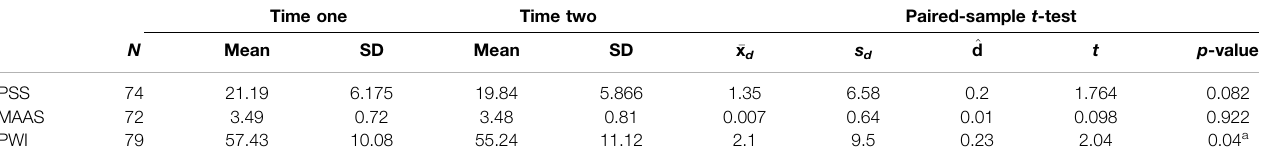
TABLE 4 | Paired Sample t -test PSS, MAAS, PWI Results Summary a . Time one Time